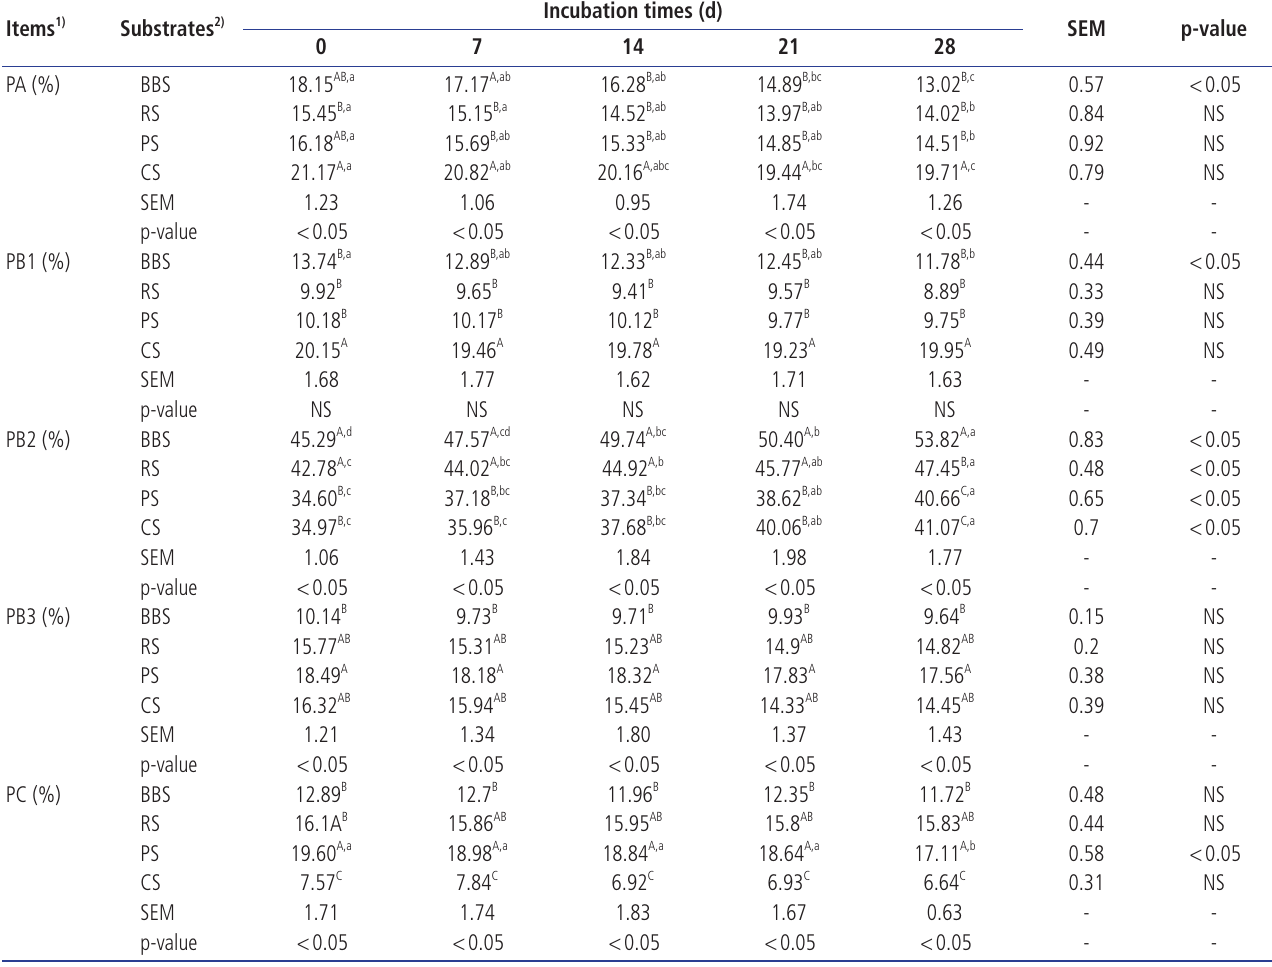
Table 3. CNCPS protein fractions (DM base) of broad bean stalks, rape straw, paddy straw and corn stalk treated with Pleurotus ostreatus for different incubation times Items 1) Substrates